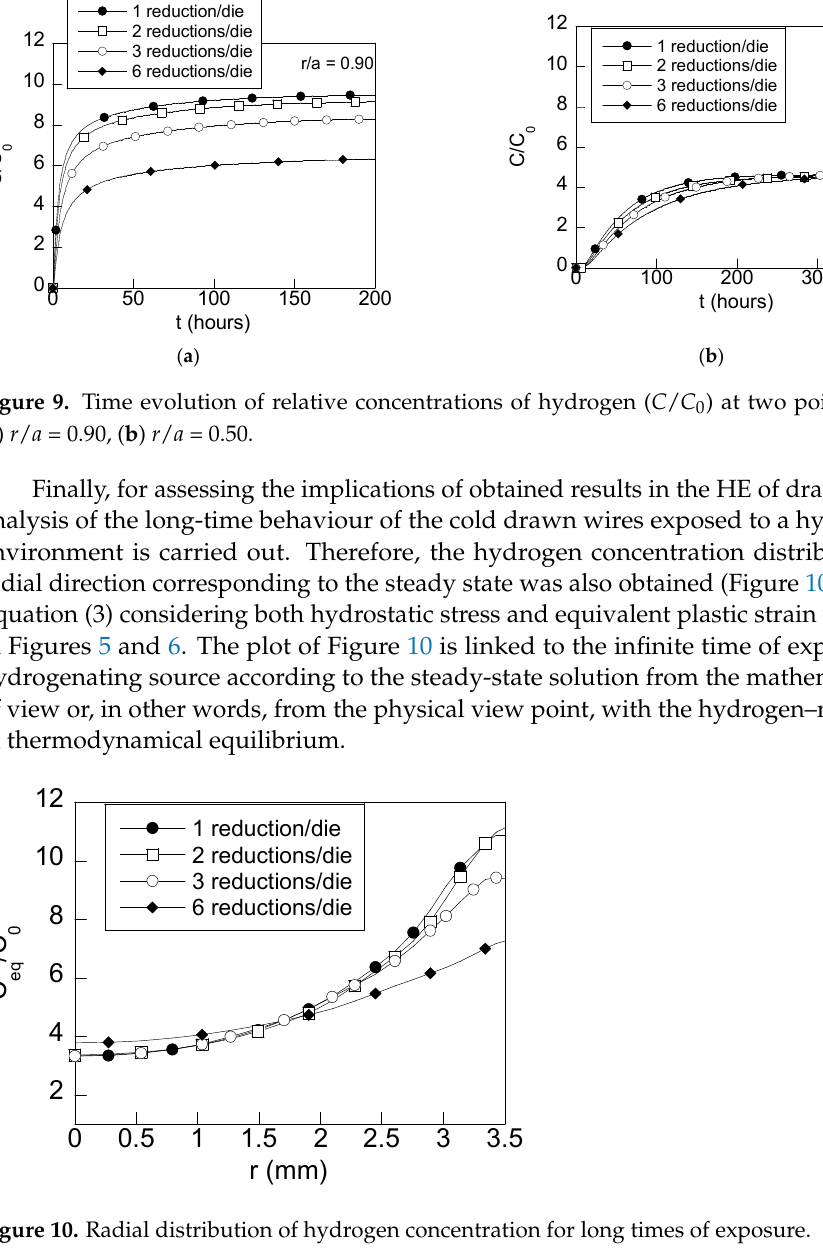
Figure 10. Radial distribution of hydrogen concentration for long times of exposure.